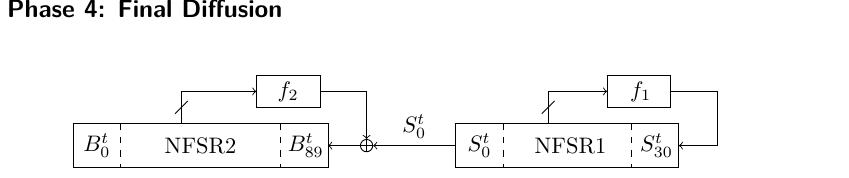
Figure 3: Lizard in phase 4 of the state initialization. The output function a is omitted as all output bits generated in this phase are